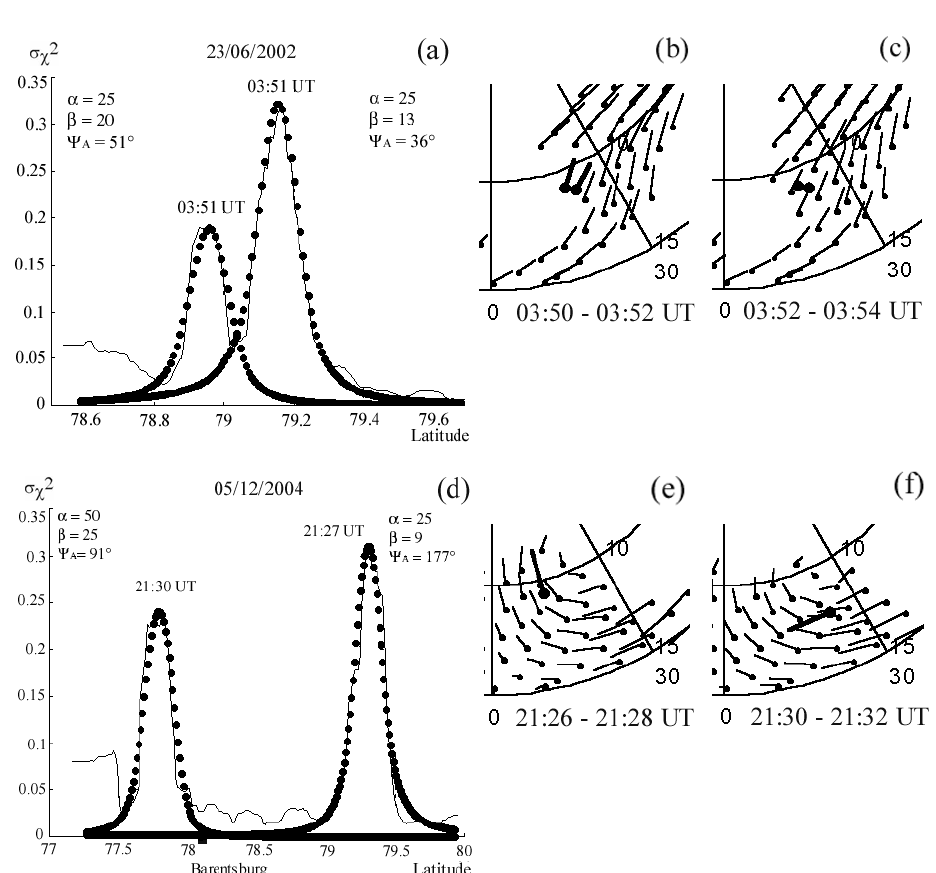
Fig. 3. The same as in Fig. 1 but for 23 June 2002 and 5 December